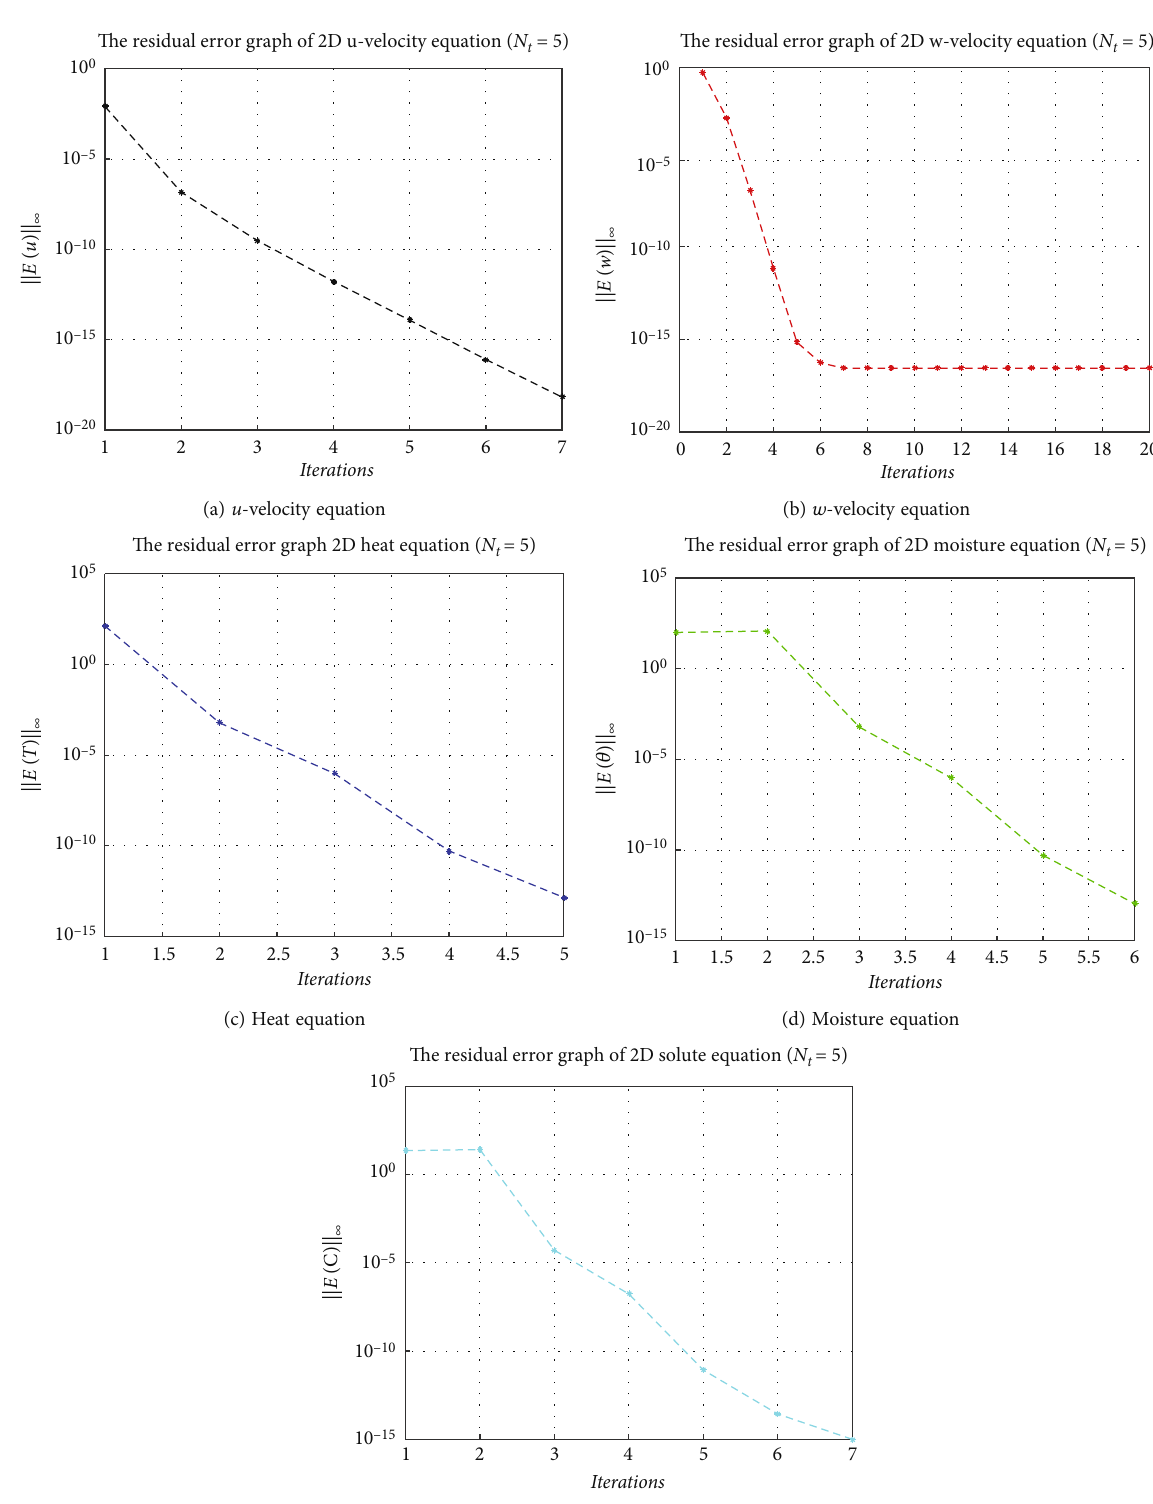
Figure 3: Error norms at di ff erent iteration points of the model, for N